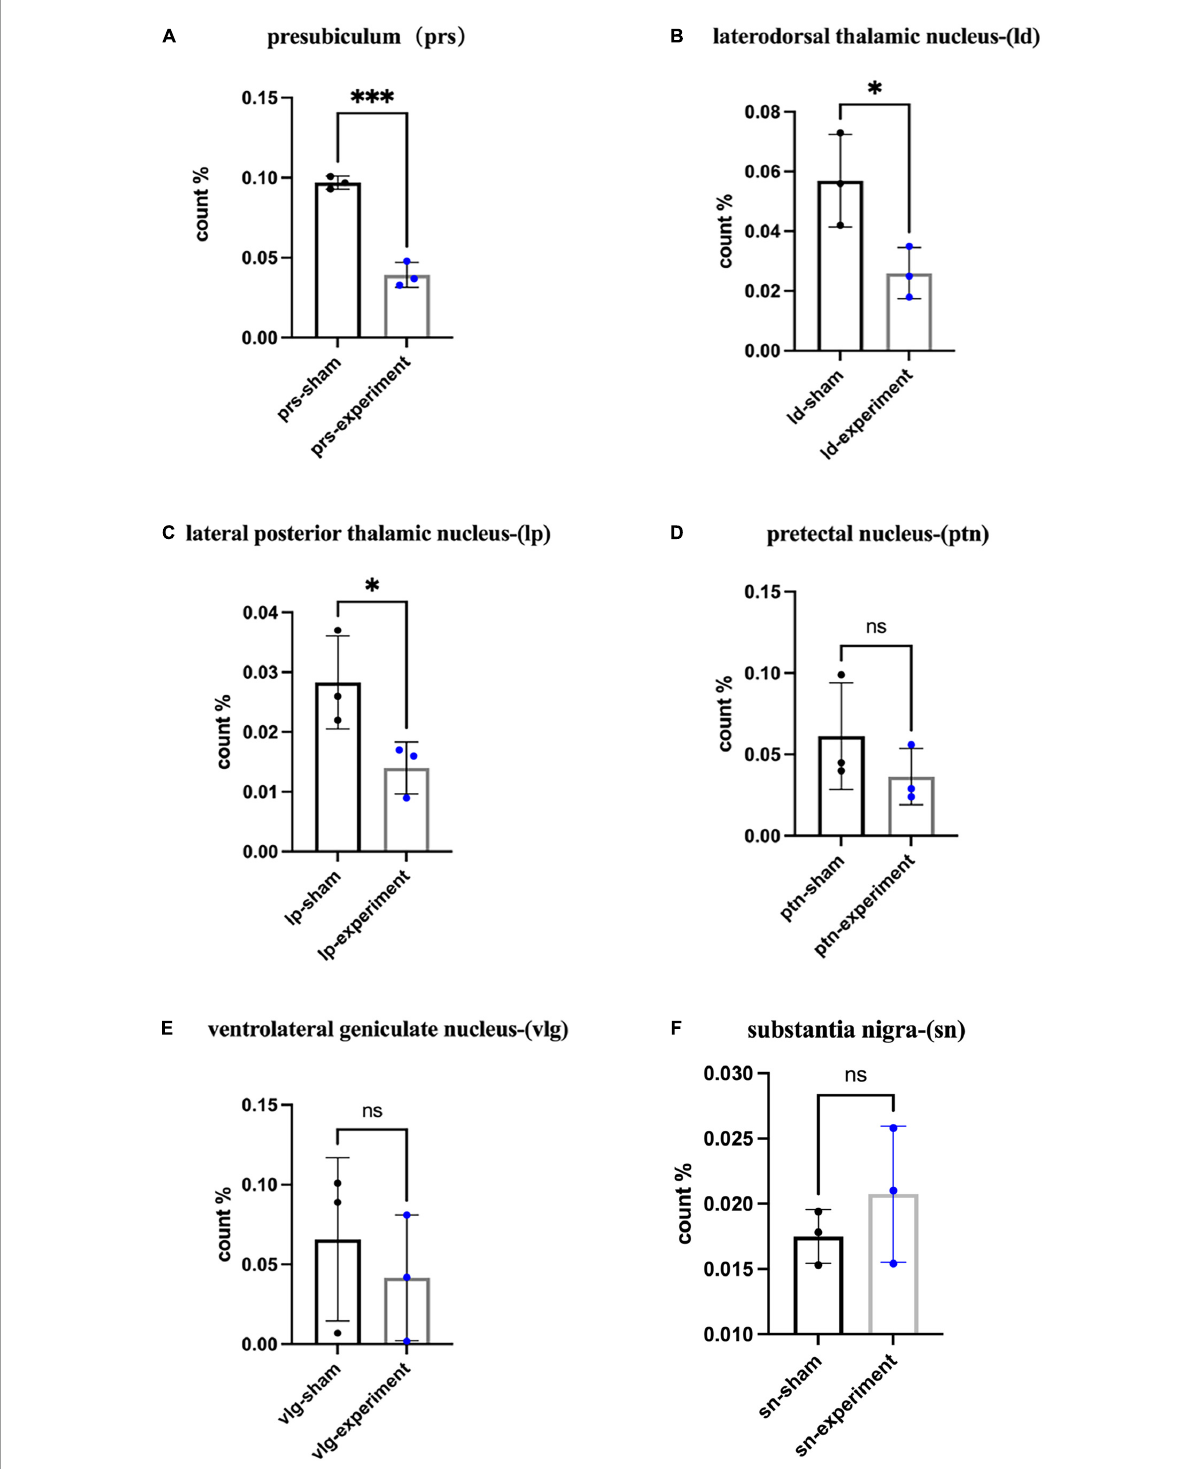
FIGURE6 The percentage of c-fos expressing cells in the target areas. (A) The ratios of the number of c-fos expressing cells in the PrS-PoS (mean ± SD, t 4 = 11.43, p = 0.0003). (B) The ratios of the number of c-fos positive cells in the LD (mean ± SD, t 4 = 3.03, p = 0.0388). (C) The ratios of the number of c-fos expressing cells in the LP-Pul (mean ± SD, t 4 = 2.78, p = 0.0494). (D) The ratios of the number of c-fos expressing cells in the PTN (mean ± SD, t 4 = 1.17, p = 0.3065). (E) The ratios of the number of c-fos expressing cells in the VLG (mean ± SD, t 4 = 0.64, p = 0.5551). (F) The ratios of the number of c-fos expressing cells in the SN (mean ± SD, t 4 = 1.00, p = 0.3739) (ratio = the number of c-fos positive neurons/size of area examined for each structure). ∗ p < 0.05, ∗∗∗ p <